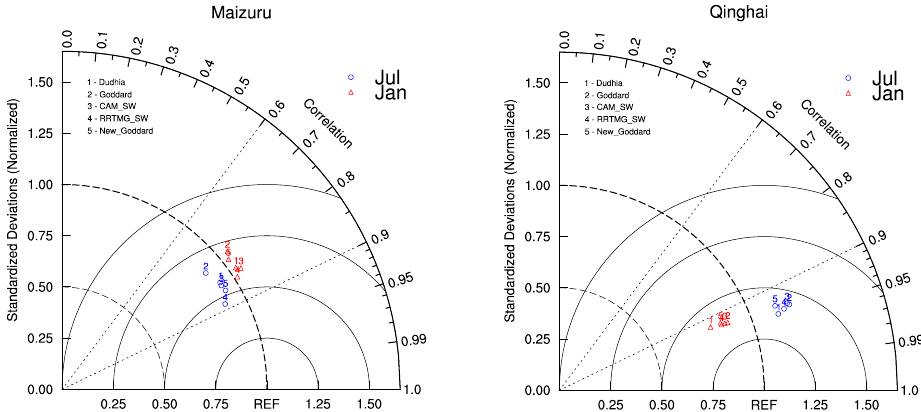
Figure 4. Taylor diagrams for Maizuru ( left ) and Qinghai ( right ) sites. The diagrams show normalized standard derivations and correlations of solar radiation forecasts for five experiments referred to observations (REF) in winter (January) and summer (July). The number of samples for each experiment is 336.